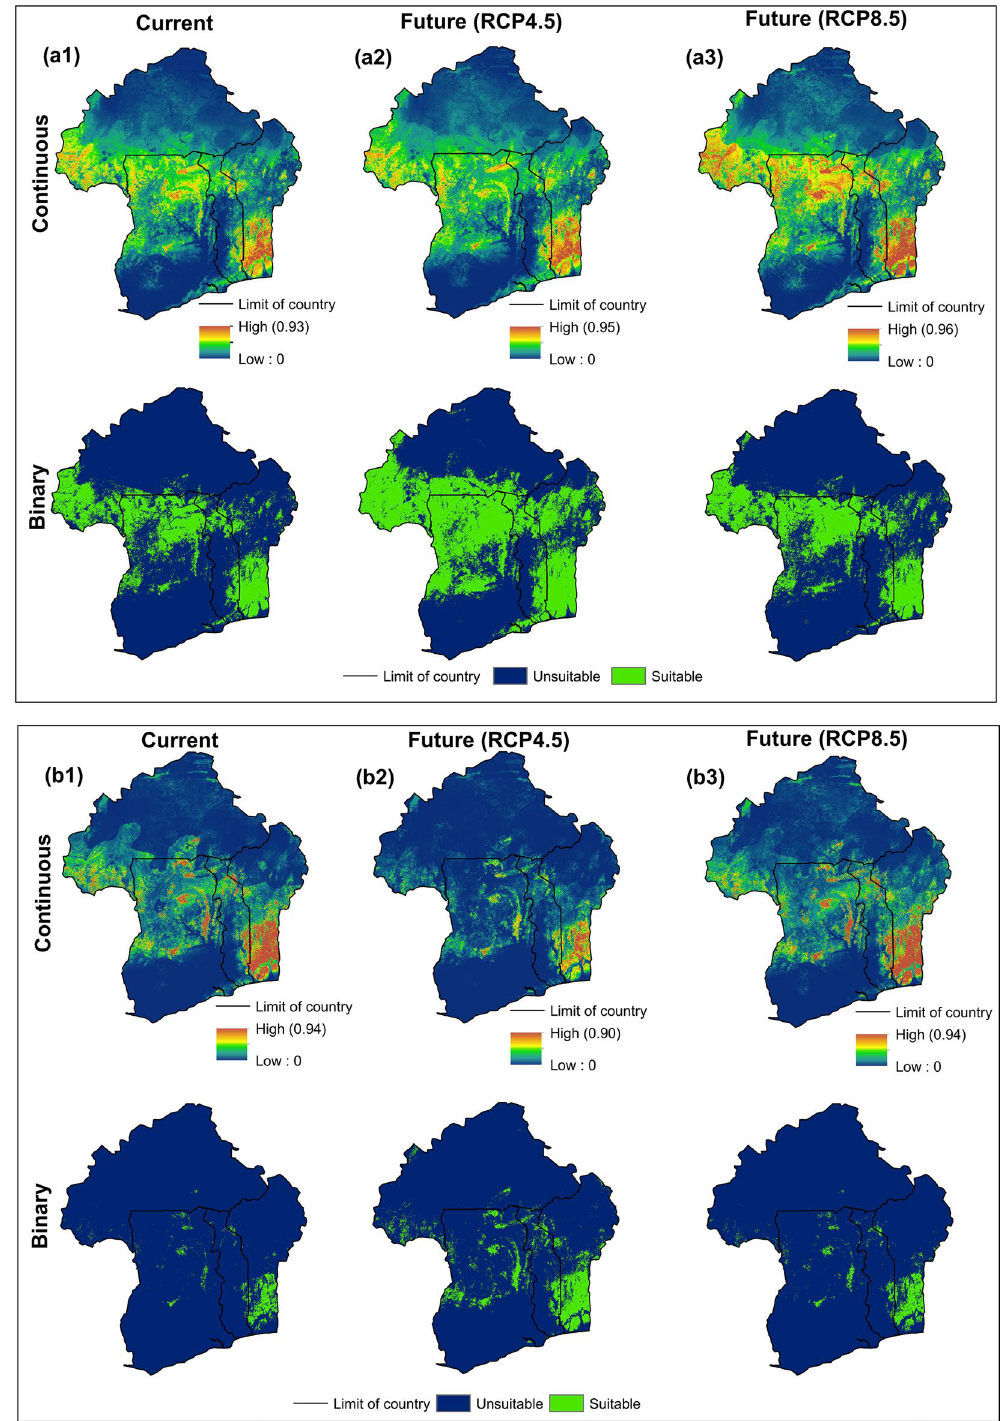
Figure 8. Binary and continuous maps showing the spatial distribution of M. geocarpum ( a1 – a3 ) and genetic Pop1 ( b1 – b3 ) and Pop2 ( c1 – c3 ) in present and the future days. Each model was set to thresholds with the 10 percentile training presence values to produce continuous and binary raster maps for current and future scenarios in ArcGIS v.